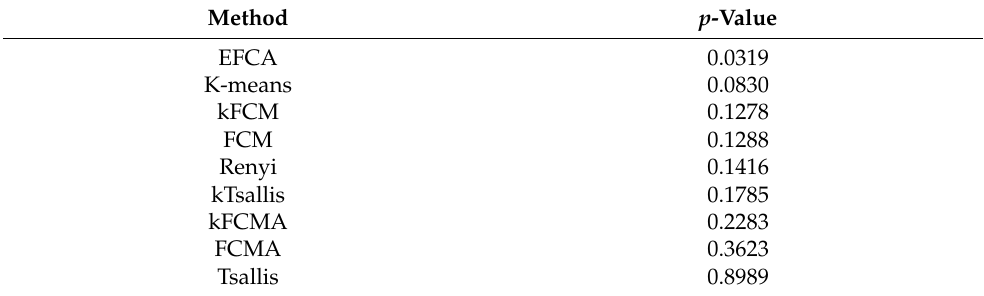
Table 7. Post hoc p -values for the comparison of the kRenyi method versus the other